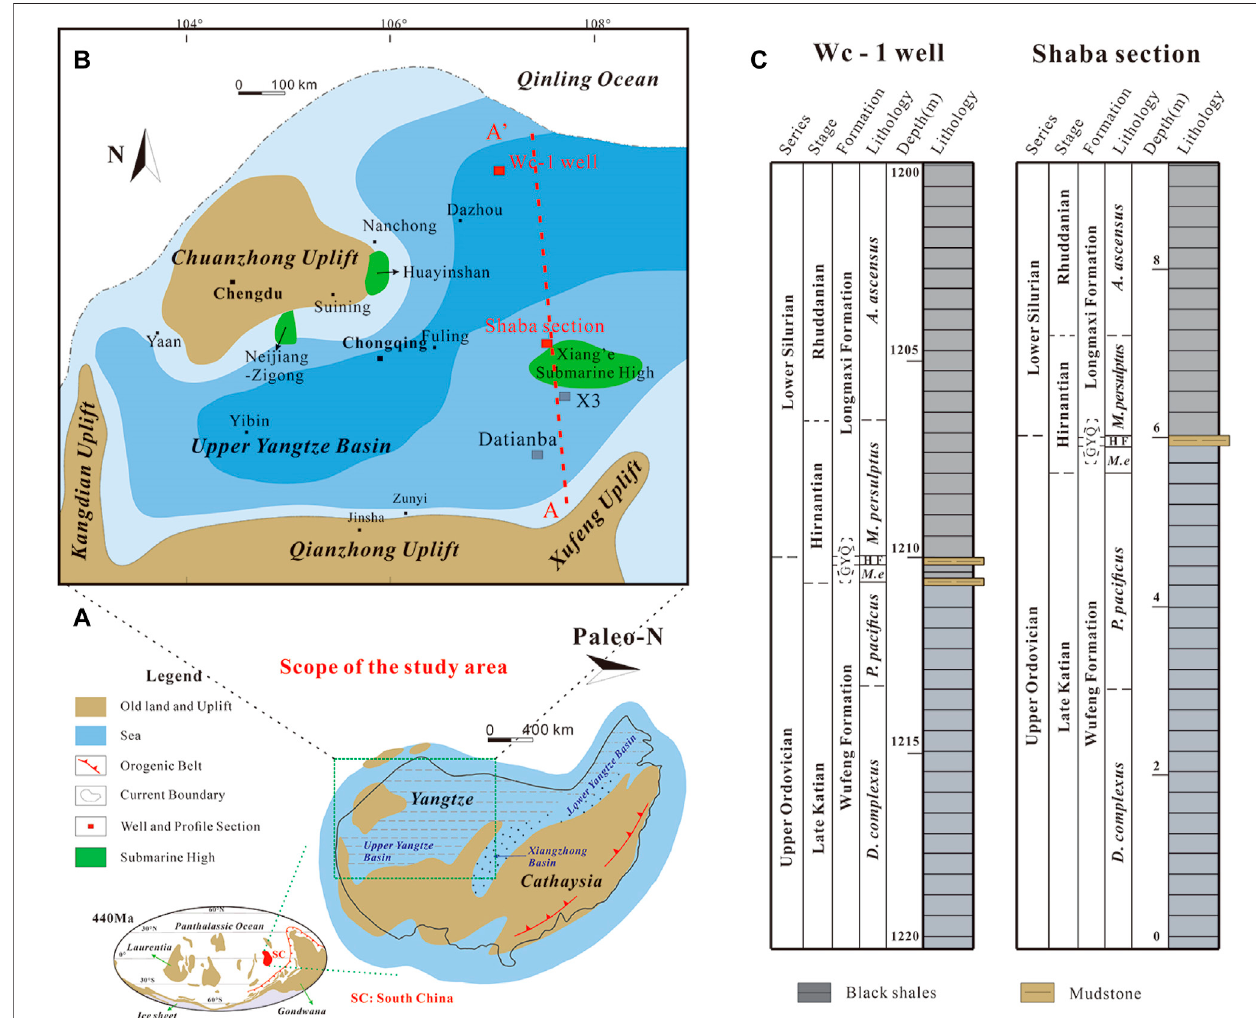
FIGURE 1 | Ancient geographical location of the study well and sections. (A) Geographical location of the Upper Yangtze Basin in South China in the Late Ordovician and distribution ofmain orogenic beltsand oceans (Zhanget al.,2015); (B) Locations ofthewell and sections ofthe Yangtze Basin inthe Early Silurian (Chen et al., 2004). (C) Biostratigraphic division of Wc-1 well and Shaba section (Chen et al., 2004).